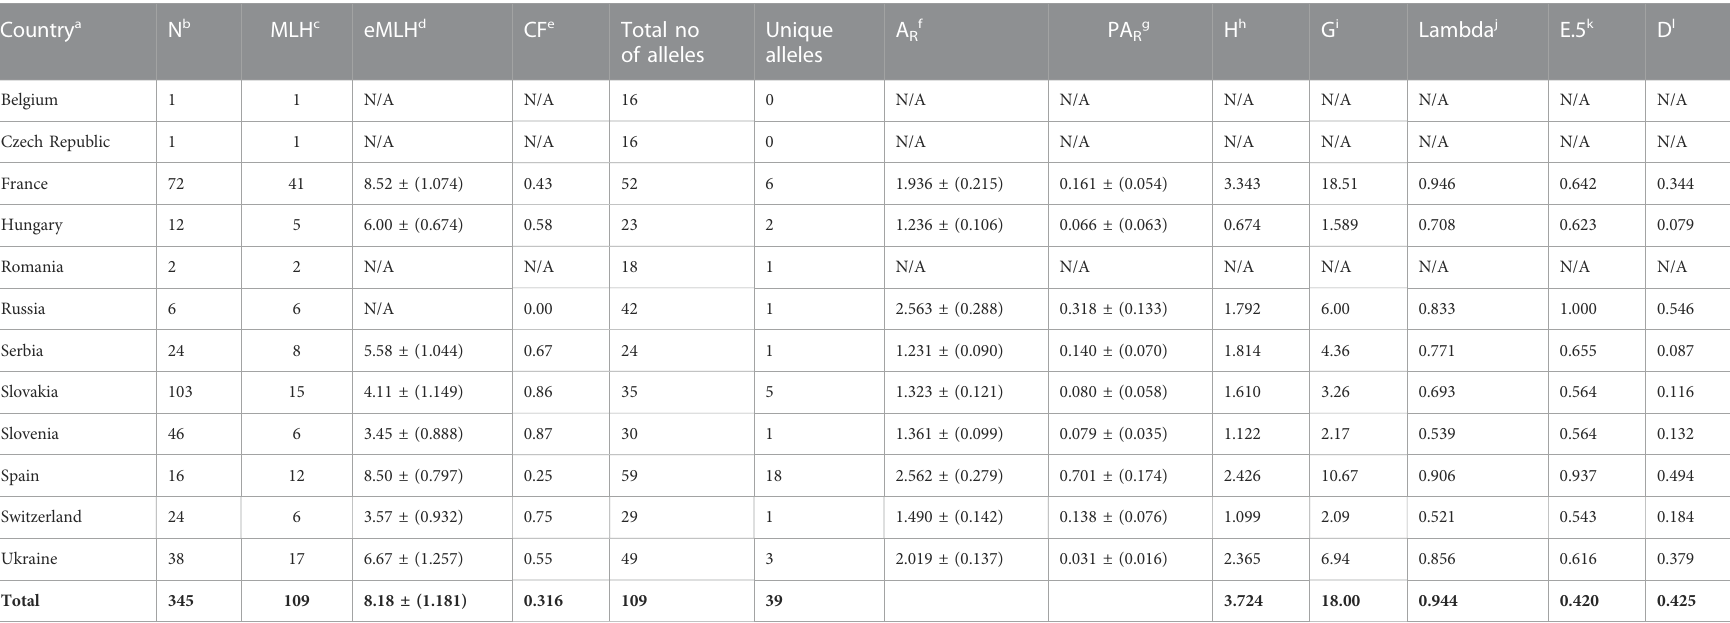
TABLE 1 Summary diversity statistics of Dothistroma pini isolates within populations by country in Europe. Country a